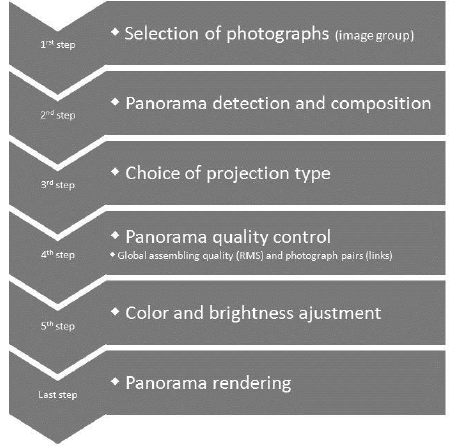
Figure 13: The panoramic photograph creation process by